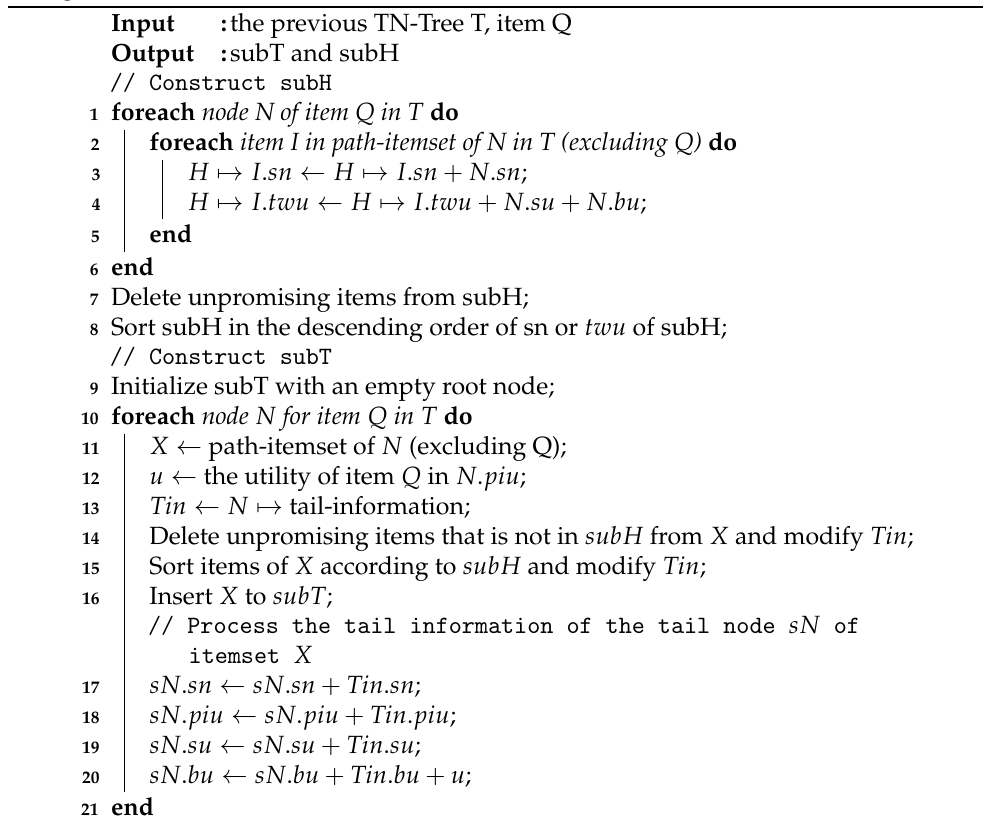
Algorithm 3: Create sub-header table and sub